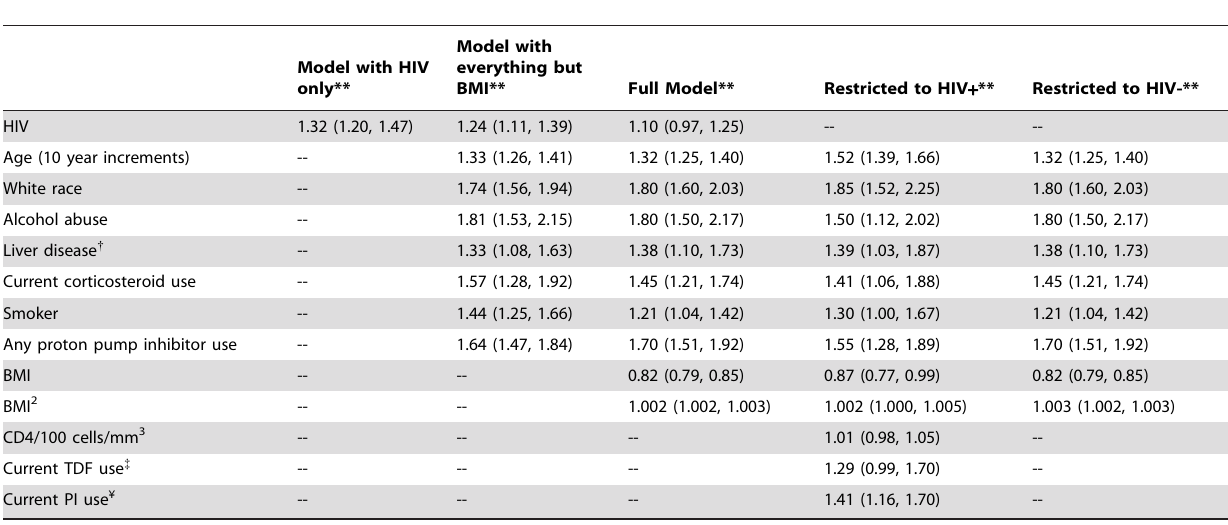
*Significant variables included in table. Other variables included in the model but not statistically significantly related to outcome: Pulmonary disease, peripheral vascular disease, major depressive disorder, coronary artery disease and/or diabetes mellitus, congestive heart failure, renal insufficiency, CD4 (per 100 cells/mm 3 ), and tenofovir use. HIV-RNA was excluded from the model as it covaried with CD4 count (Pearson’s R: 0.30) and only CD4 count was significantly associated with fragility fractures. **Hazard ratio (95% confidence interval). { Includes end stage liver disease, cirrhosis, chronic hepatitis B or C infection. { TDF: tenofovir. ¥ PI: protease